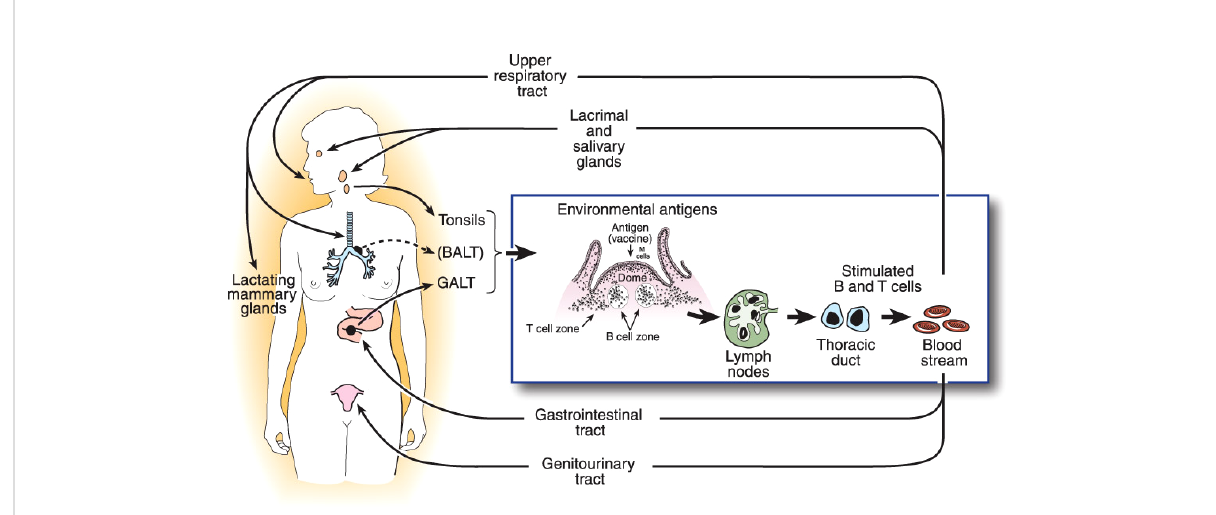
FIGURE 1 The common mucosal immune system, illustrating the origin of antigen-stimulated, IgA-committed B cells and cognate T cells in inductive sites, mainly the organized mucosa-associated lymphoid tissues of the respiratory and intestinal tracts, i.e., the palatine, tubal, and lingual tonsils and adenoids, and the gut-associated lymphoid tissues (GALT) i.e., small intestinal Peyer ’ s patches and large intestinal follicles, respectively. Note that bronchus-associated lymphoid tissue (BALT) does not usually occur in healthy adults, but can be found in children, or be induced by infection (52). Antigen-stimulated B and T cells emigrate and traf fi c through mesenteric lymph nodes into the circulation, and ultimately home into the lamina propria of respiratory, intestinal, and genital tracts and stroma of salivary, lacrimal, and lactating mammary glands, etc. Homing of cells into mucosal effector sites is orchestrated by the expression of vascular endothelial addressins and production of chemokine ligands in mucosal effector sites, and corresponding integrins and chemokine receptors expressed on B and T cells induced in mucosal inductive sites. Terminal differentiation of B cells into pIgA-secreting plasma cells occurs in these effector sites with help from T cells and locally produced cytokines. SIgA is formed by the pIgR-mediated epithelial transport of this locally synthesized pIgA into the secretions, the extracellular part of pIgR becoming the secretory component of